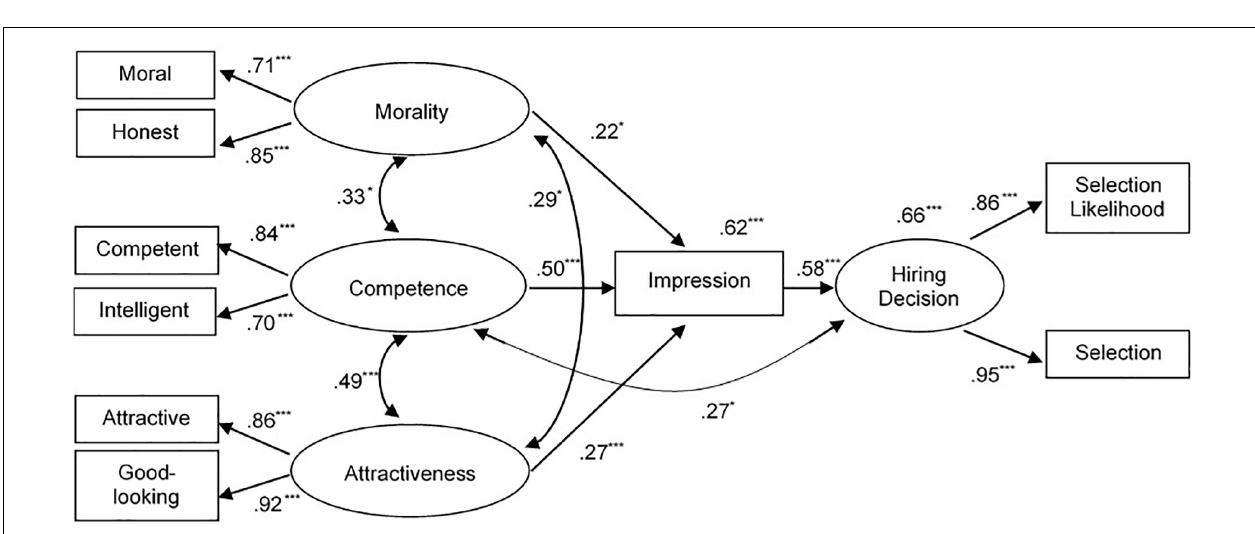
FIGURE 2 | Structural equation model for male applicants. Values reported above impression and hiring decision indicate portions of explained variance. * p < 0.05; ** p < 0.01; *** p < 0.001.